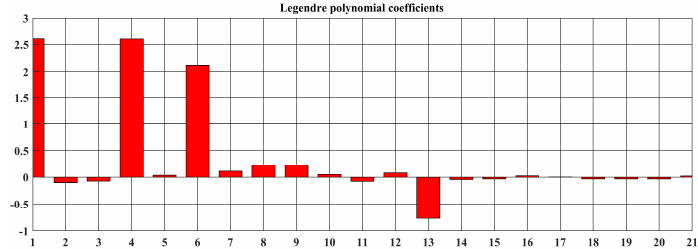
Figure 6. 2D Legendre polynomial coefficients for wavefront distortion with fixed O-rings at 1 Hz.